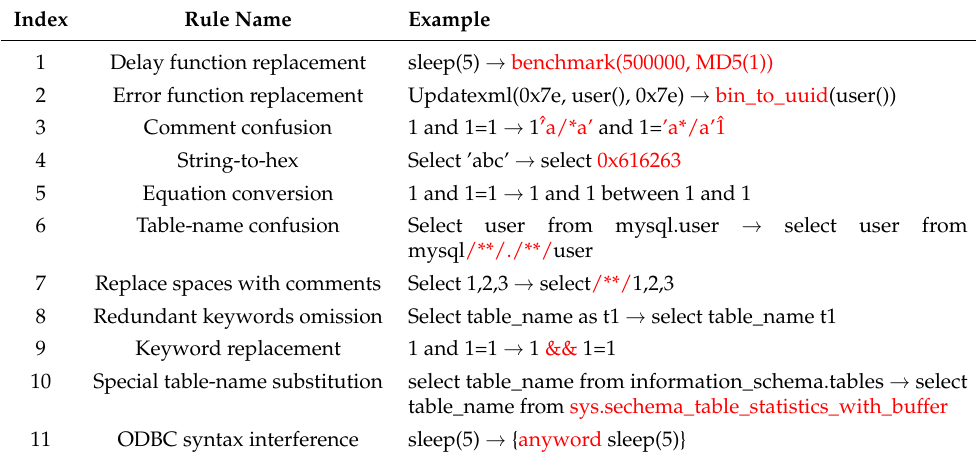
Table 2. The example of syntactic transformation